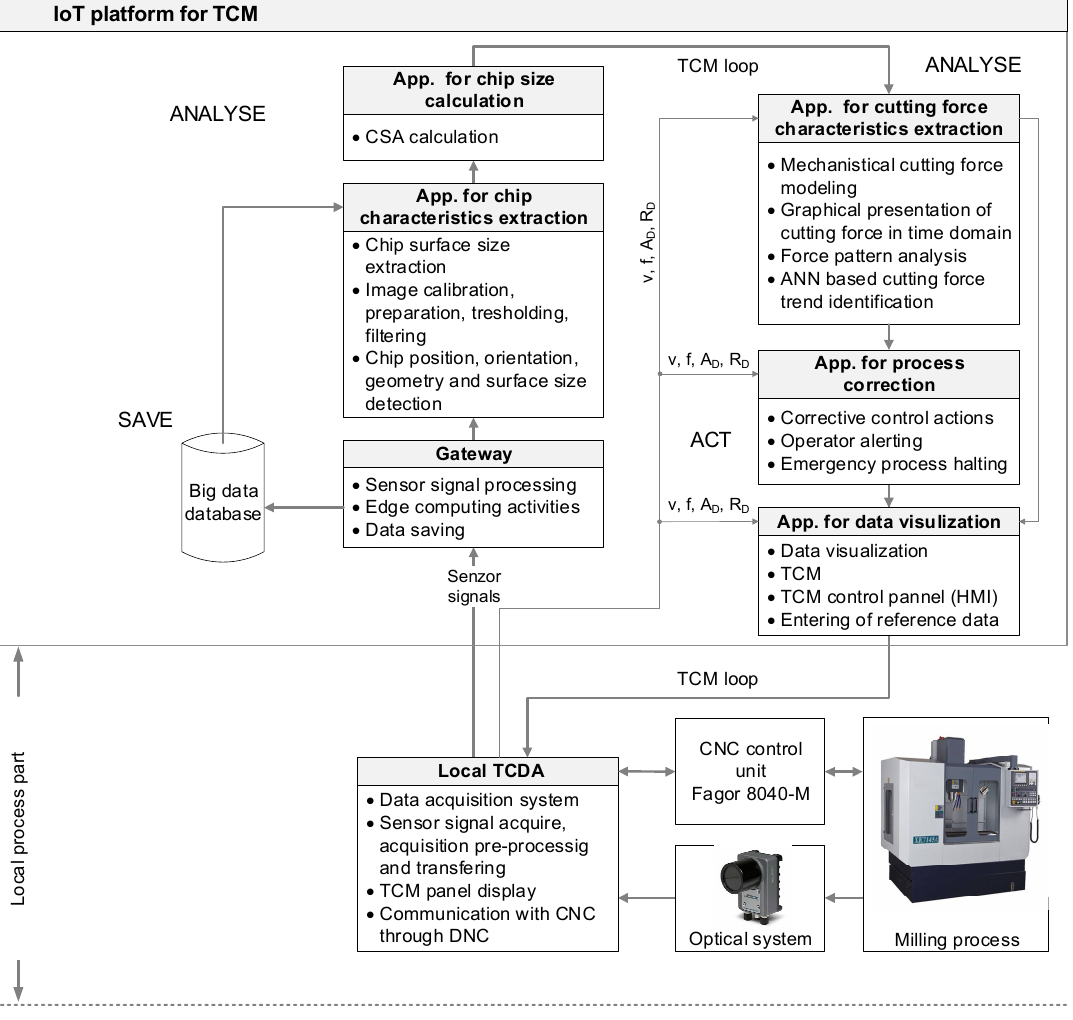
Figure 2. The basic structure of the cloud-based TCM system.